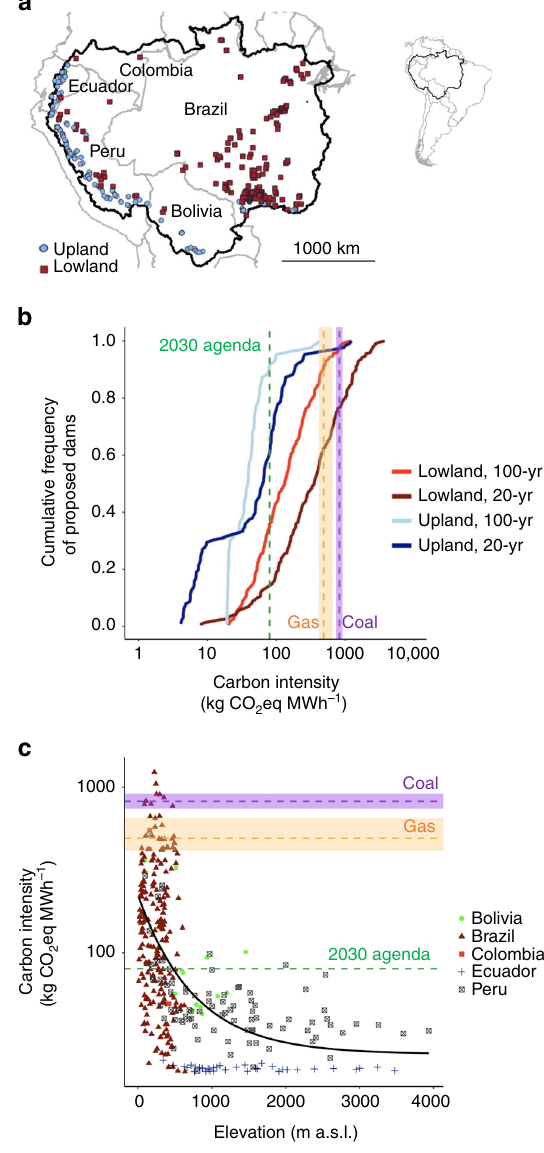
Fig. 1 Carbon intensity of proposed Amazon hydropower dams. A total of 351 dams (>1 MW) have been proposed in fi ve different countries of the Amazon basin, 65% in elevations below 500 m a.s.l. (lowland) and 35% above 500 m a.s.l. (upland) ( a ). b Cumulative frequency of lowland (< 500 m a.s.l.) and upland (> 500 m a.s.l.) dams proposed for the Amazon basin with respect to predicted carbon intensities over 20- and 100-year time horizons. c Carbon intensities of proposed dams (100-year time horizon) plotted against elevation above sea level. Point colors correspond to the countries where each dam is located. Green dashed lines (80 kg CO 2 eq MWh − 1 ) indicate the projected carbon intensity of the global electricity sector in 2040 based on a scenario consistent with the UN 2030 Agenda for Sustainable Development 23 . The ranges of carbon intensities of coal- and natural gas- fi red power plants reported by the IPCC are shown in the purple and orange areas, respectively, with medians indicated by horizontal dashed lines